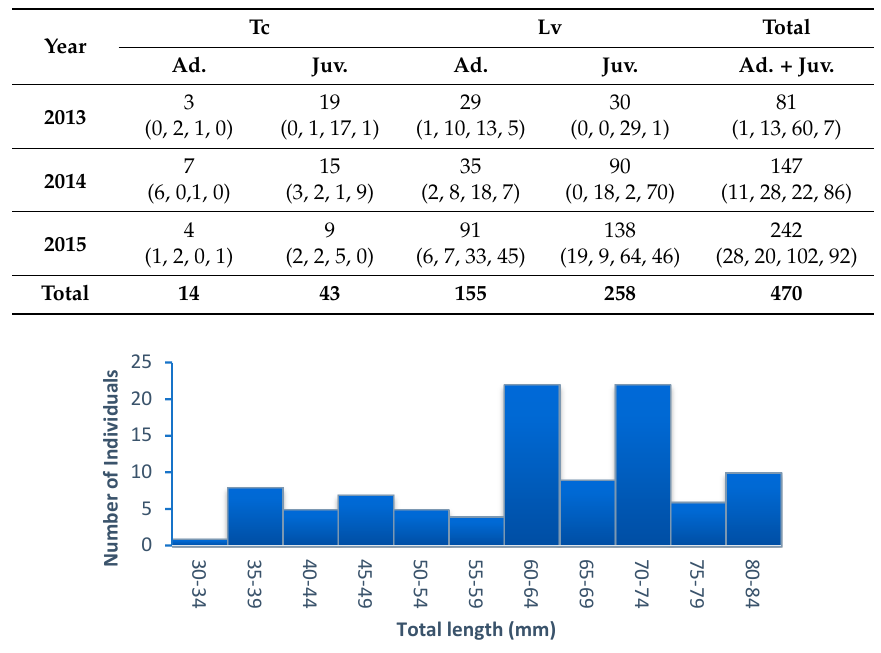
Table 3. Numbers of adults (Ad.) and juveniles (Juv.) of Great Crested Triturus cristatus (Tc) and Smooth Lissotriton vulgaris (Lv) newts observed outside Hotels 1–4 in 2013–2015. The total numbers are given, with the numbers in H1, H2, H3 and H4 provided in parenthesis.